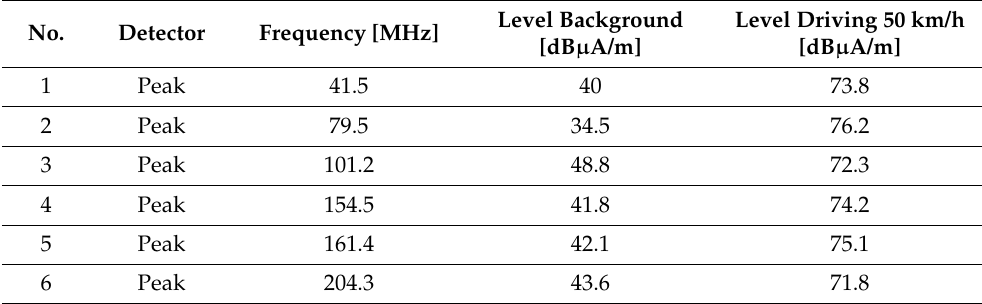
Table 5. Measurement method and results were obtained for individual frequencies, for a rail vehicle travelling at a speed of 50 km/h and the electromagnetic